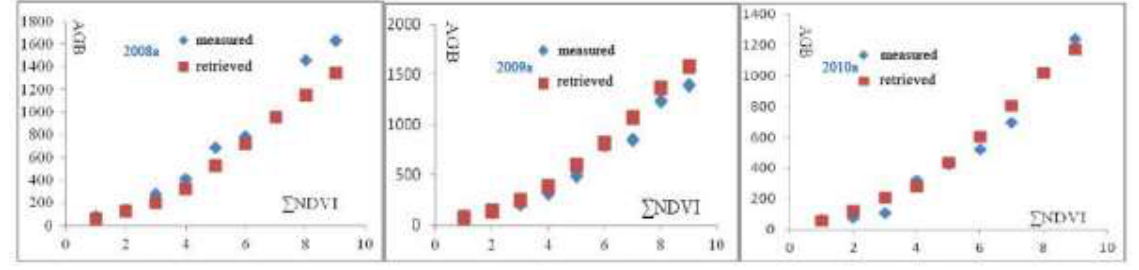
Figure 3. The sketch of AGB in situ observation and retrieved from remote sensing in 2008-2010a